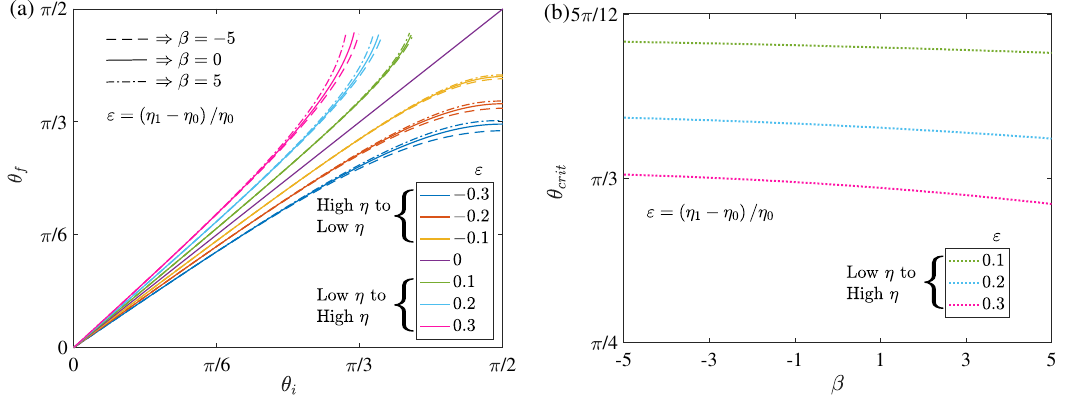
Figure 4. The reorientation of active particles that cross the interface ( a ) and the critical orientation required for scattering from the interface ( b ). Here, the solid, dashed, and dash-dotted lines in ( a ) correspond to the neutral swimmers β = 0 , pushers β = − 5 , and pullers β = 5 , respectively. On the other hand, the different line colors in ( a ), ( b ) represent different viscosity jumps ε